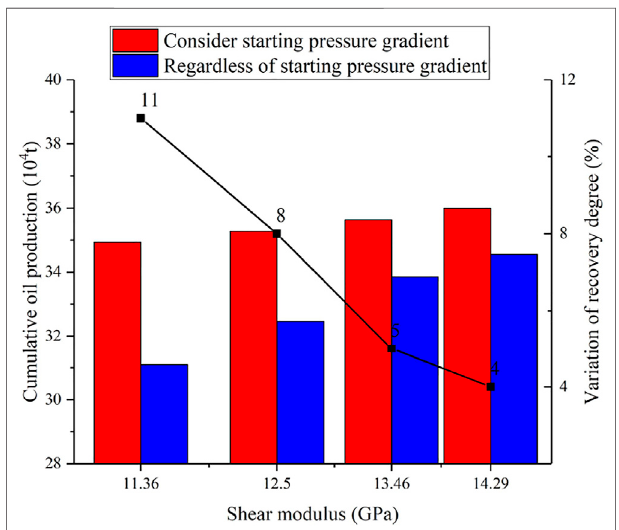
FIGURE 9 | Cumulative oil production under different shear modulus